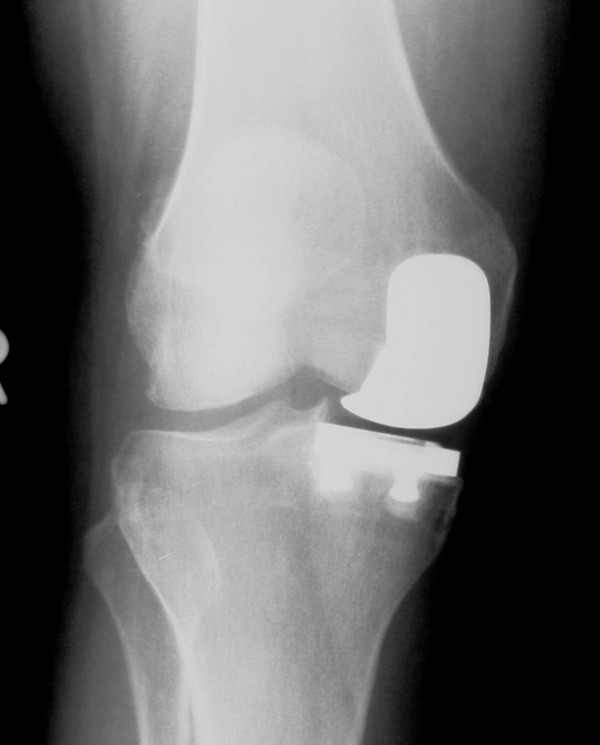
Post-operative antero-posterior radiograph of the same patient shown in Figure 1 at 6 week follow-up visit.